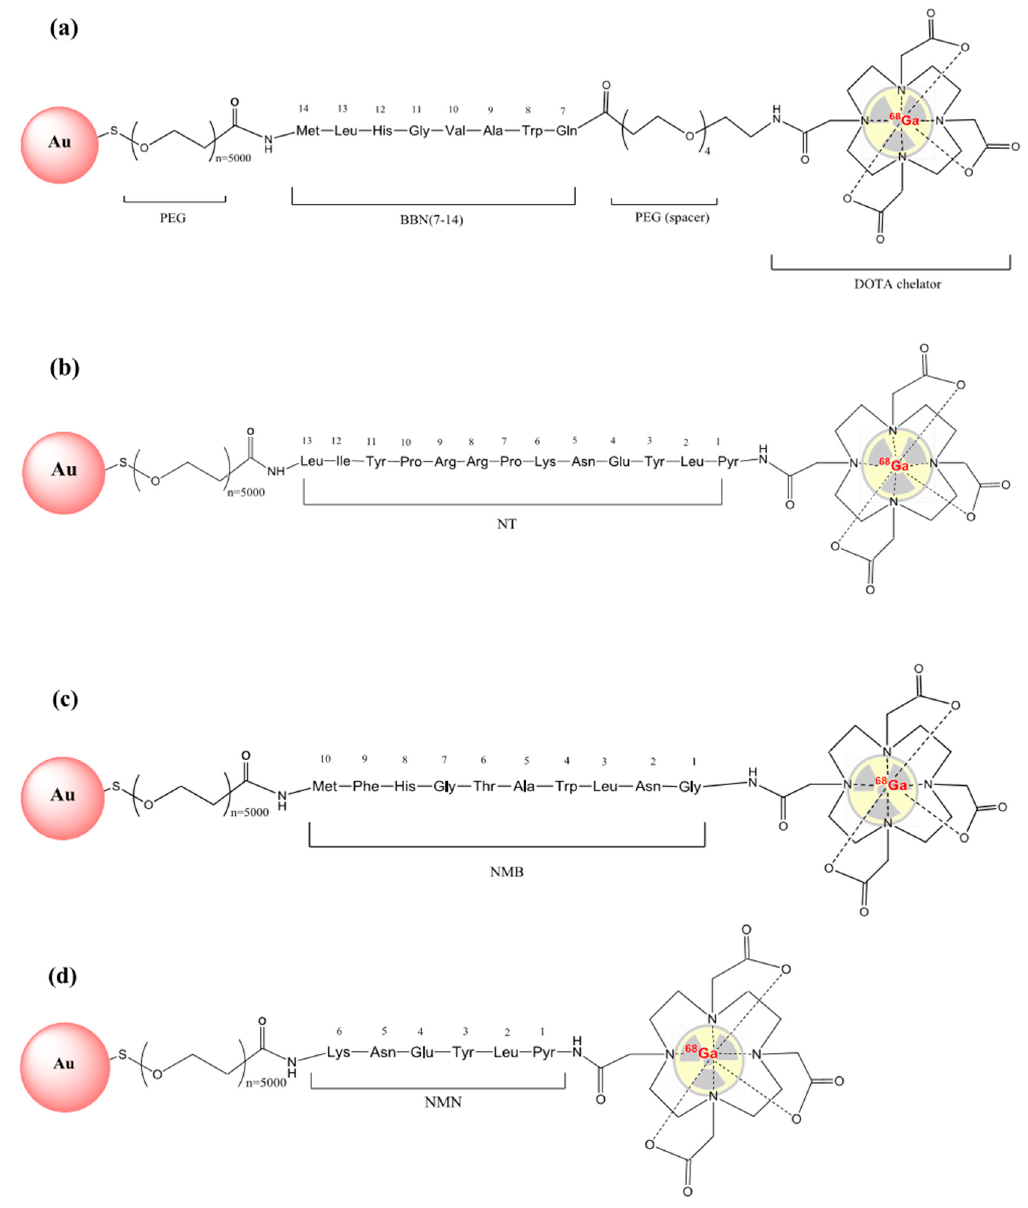
Figure 9. The structure of peptide ‐ AuNP nanocarriers labelled with 68 Ga: ( a ) 68 Ga ‐ DOTA ‐ PEG(4) ‐ BBN(7 ‐ 14) ‐ AuNP; ( b ) 68 Ga ‐ DOTA ‐ NT ‐ AuNP; ( c ) 68 Ga ‐ DOTA ‐ NMB ‐ AuNP; ( d ) 68 Ga ‐ DOTA ‐ NMN ‐ AuNP.